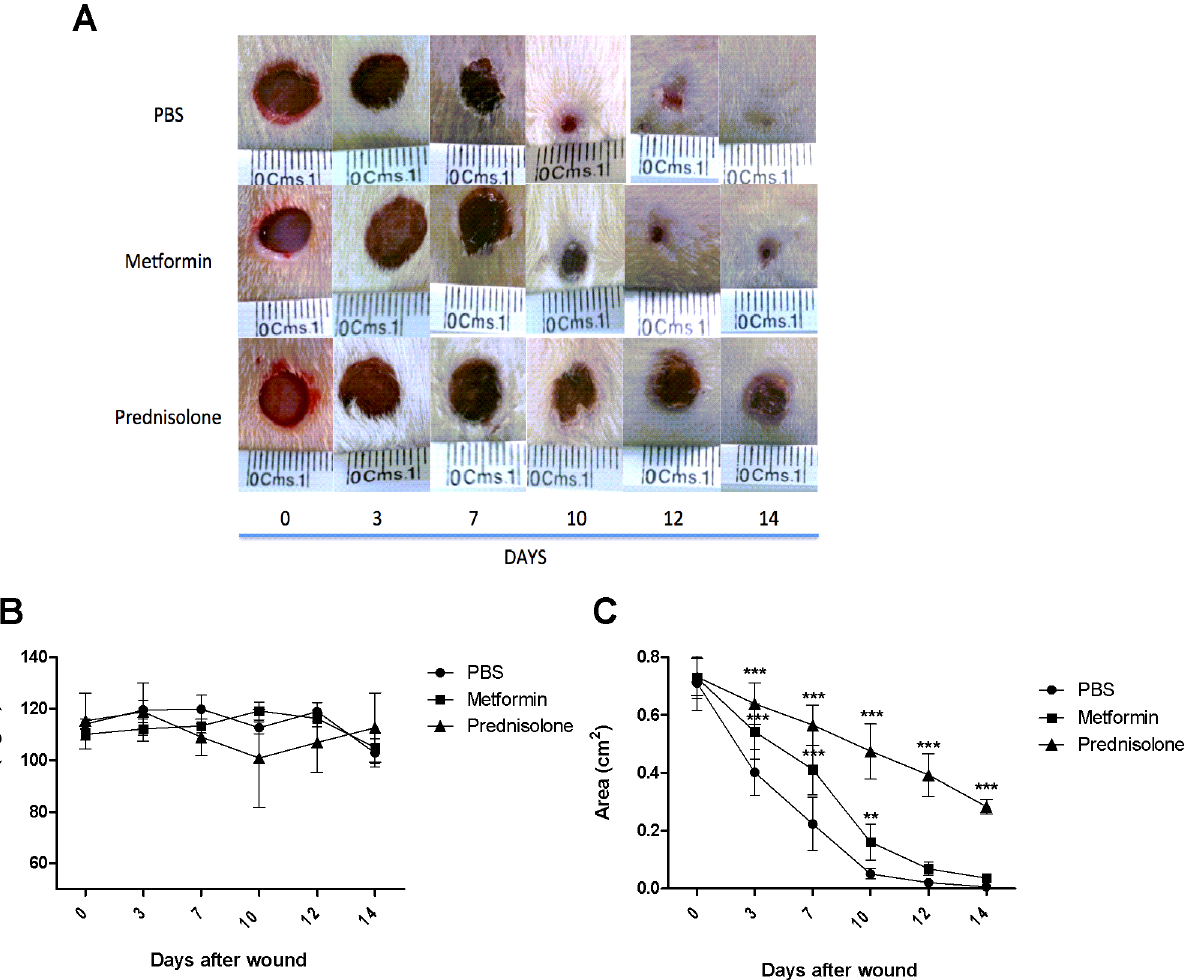
Fig 4. Metformin inhibits wound healing in vivo . A rat model of wound healing was used to evaluate the effect of metformin on cell proliferation and wound closure. (A) The panel shows the effect of metformin (300mg/kg) in the healing of a standardized model of wound healing, PBS was used as a control and topical prednisolone (0.25 mg) has been used in this model as control of delayed healing. Representative photographs of each time point are shown. (B) Glucose concentrations were measured daily in the animals by means of a portable glucometer (mg/dl), to monitor the effect of metformin compared to PBS and prednisolone treatment. (C) Ulcer diameters were measured from the referenced images using Image J, the ruler in each photograph was used as a standard to set scale for each image. Groups of animals of N = 12 animals per treatment group were used for the experiments in two independent experiments. Analyses of glucose and area differences were made by means of a Two-way ANOVA. P < 0.05 was considered statistically